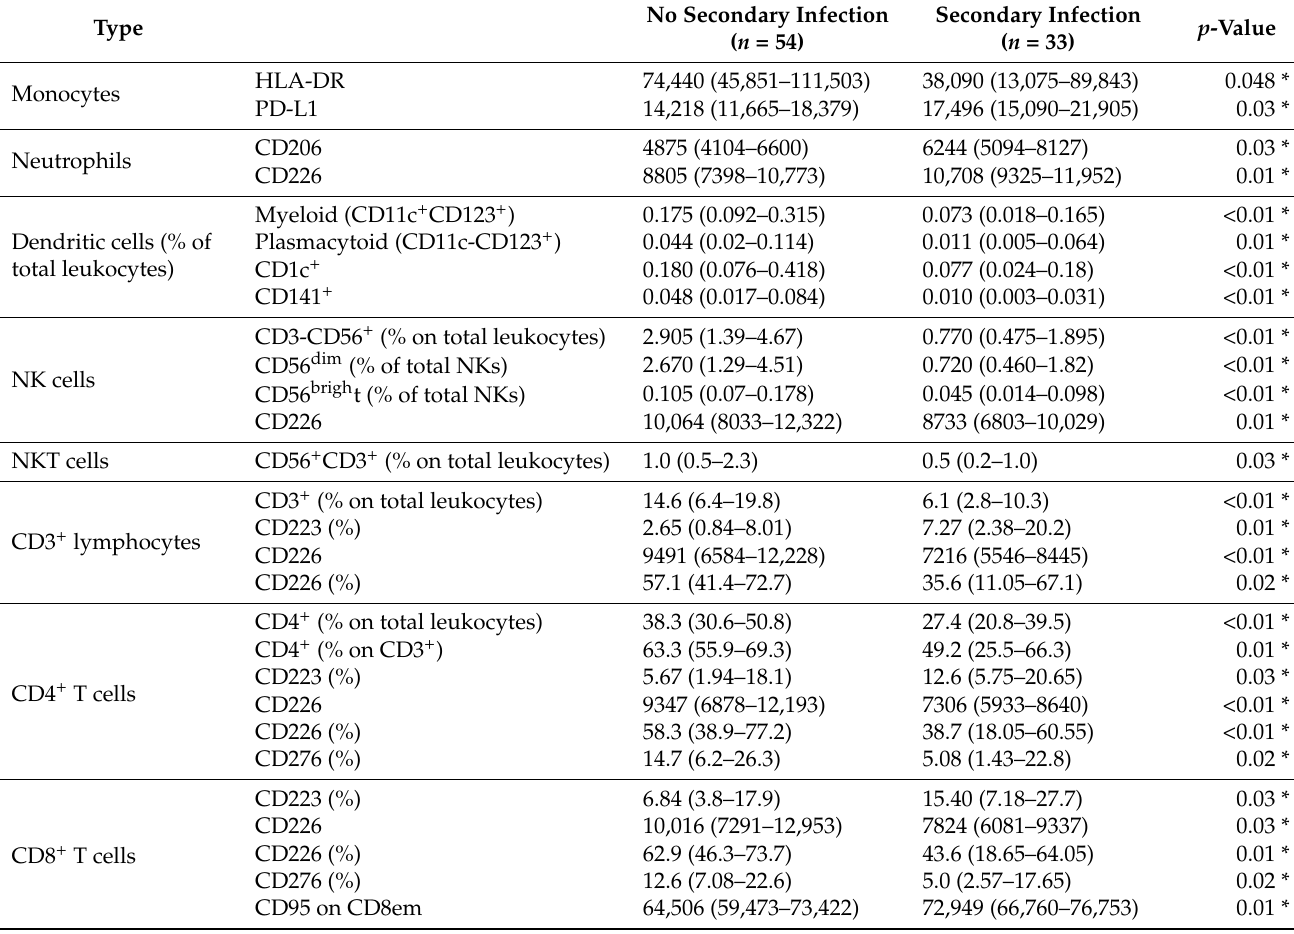
Table 2. Immune subpopulations, immune checkpoints and activation markers expression at ad- mission in COVID-19 patients classified according to whether they developed a secondary infection during their hospital